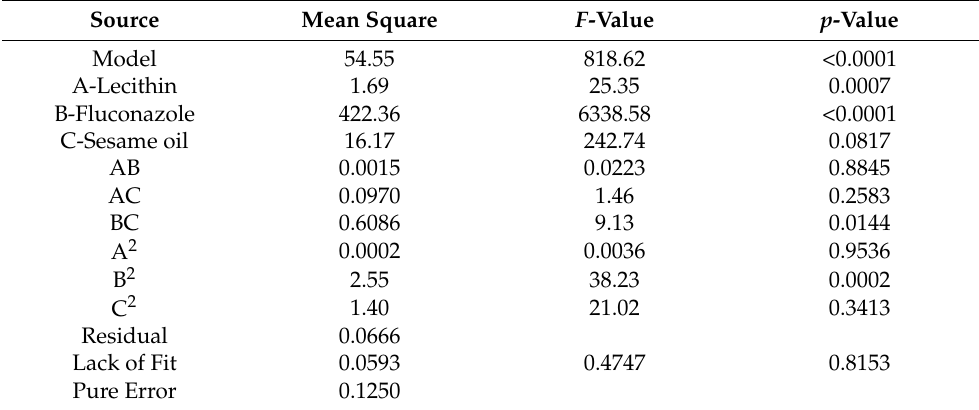
Table 5. Statistical outcome (ANOVA) of the interactions of three independent variables on the zone of inhibition of the